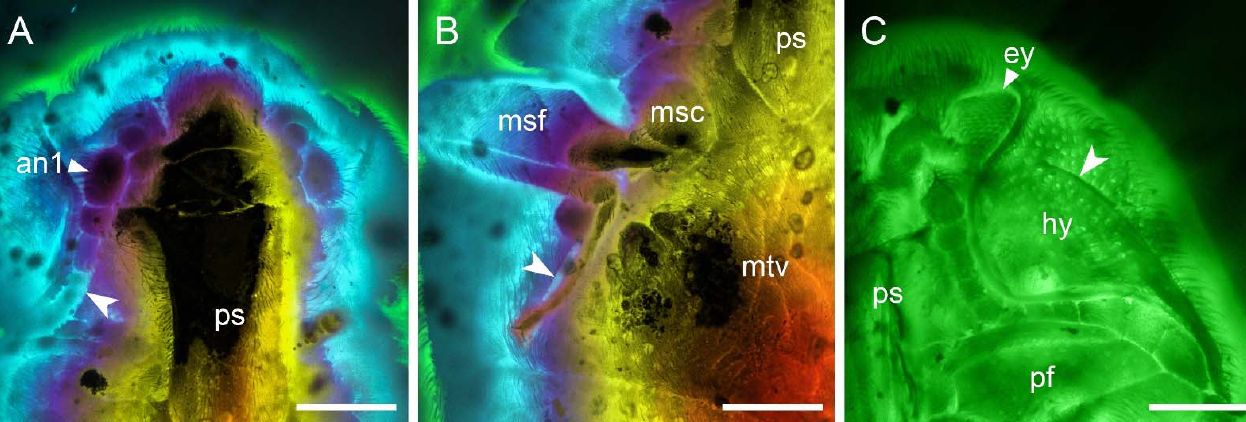
Figure 9. General habitus of Pseudopactopus robustus gen. et sp. nov. , paratype, NIGP173918 ( A ) Dorsal view, under incident light. ( B ) Ventral view, under incident light. ( C ) Ventral view, under widefield fluorescence. Scale bars: 500 μ m.